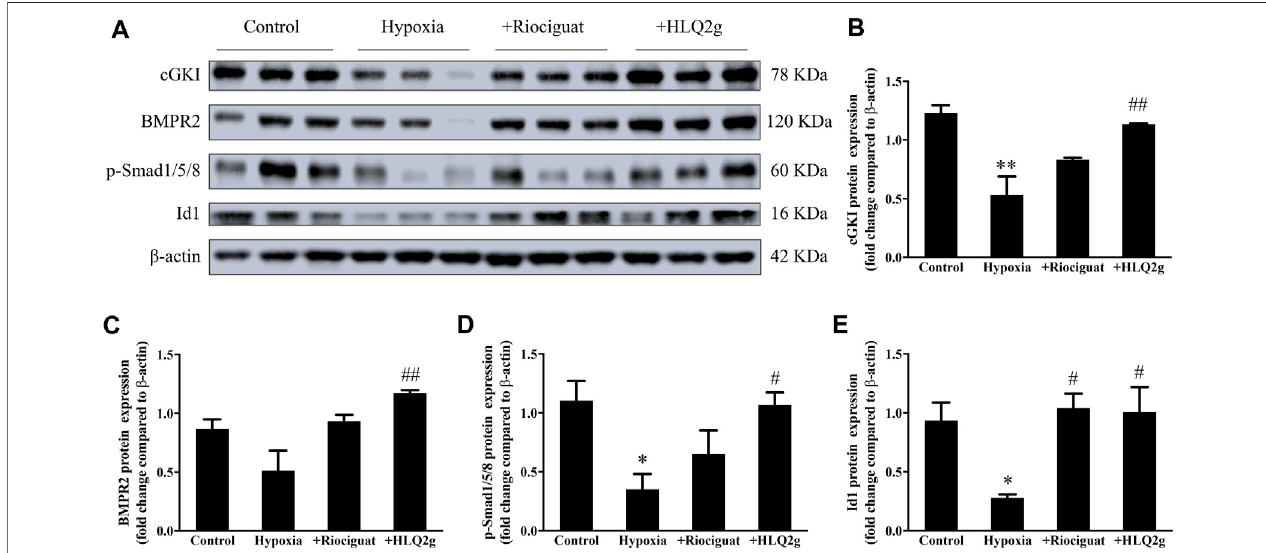
FIGURE 3 | In hypoxia-induced PH rat model, HLQ2g can regulate cGKI protein and BMPR2 pathway. (A) : The expression of cGKI, BMPR2, p-Smad1/5/8, and Id1 in pulmonary artery of rats; (B – E) : The quantitative analysis results of A. Control: the control rats; Hypoxia: Hypoxia-induced PH rats. Data are expressed as mean ± SD. n (cid:1) 3. Vs. the control, * p < 0.05, ** p < 0.01; vs. the Hypoxia group, # p < 0.05, ## p <